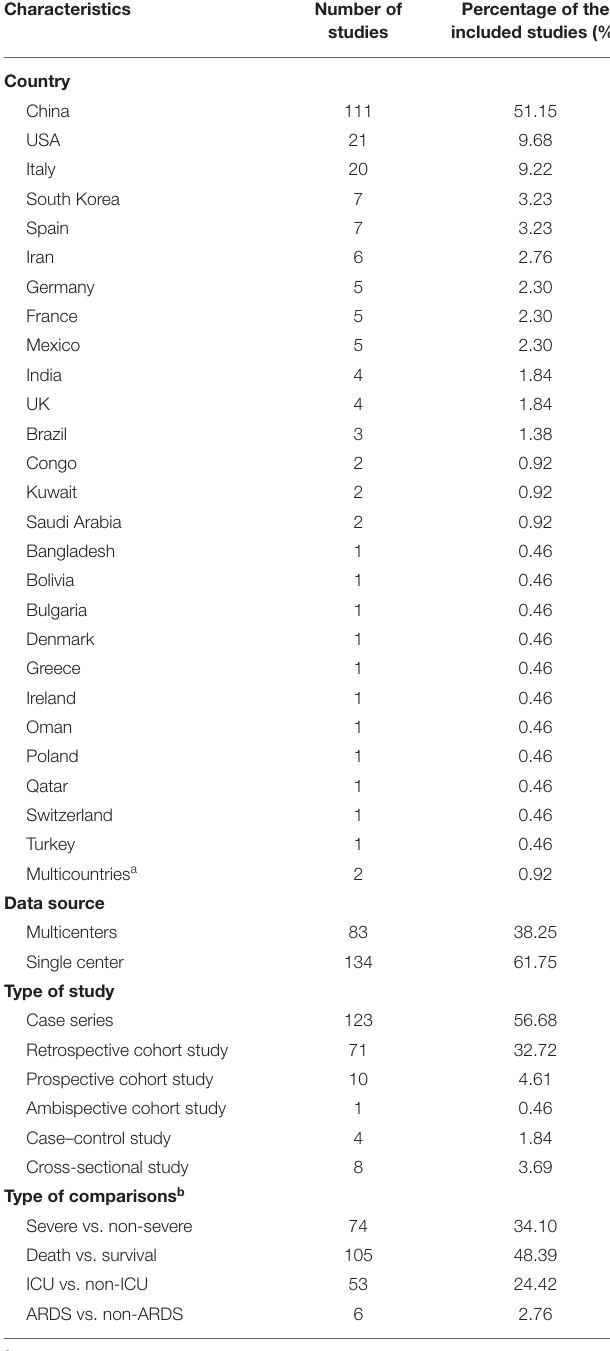
TABLE 1 | Characteristics of the included studies. Characteristics Number of